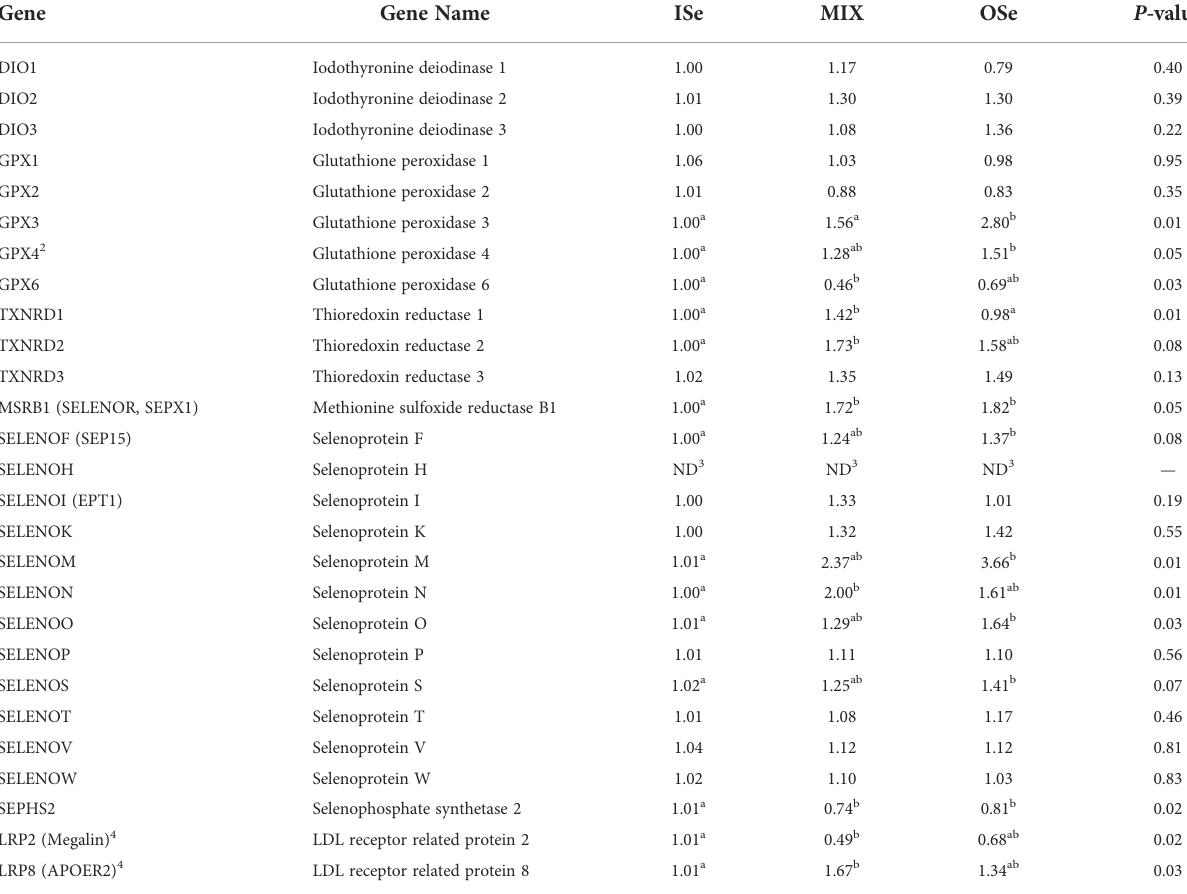
TABLE 4 Real-time RT-PCR-determined relative expression of selenoprotein genes in pituitary tissue of steers grazing endophyte-infected tall fescue and supplemented with 3 mg Se/d in vitamin-mineral mixes as either sodium selenite (ISe), SEL-PLEX (OSe), or a 1:1 mix of ISe and OSe (MIX) 1